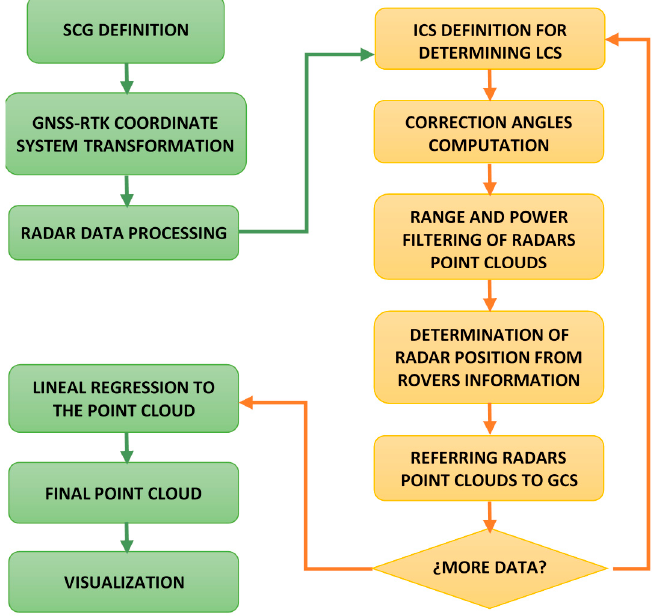
Figure A2. Data processing flow chart.